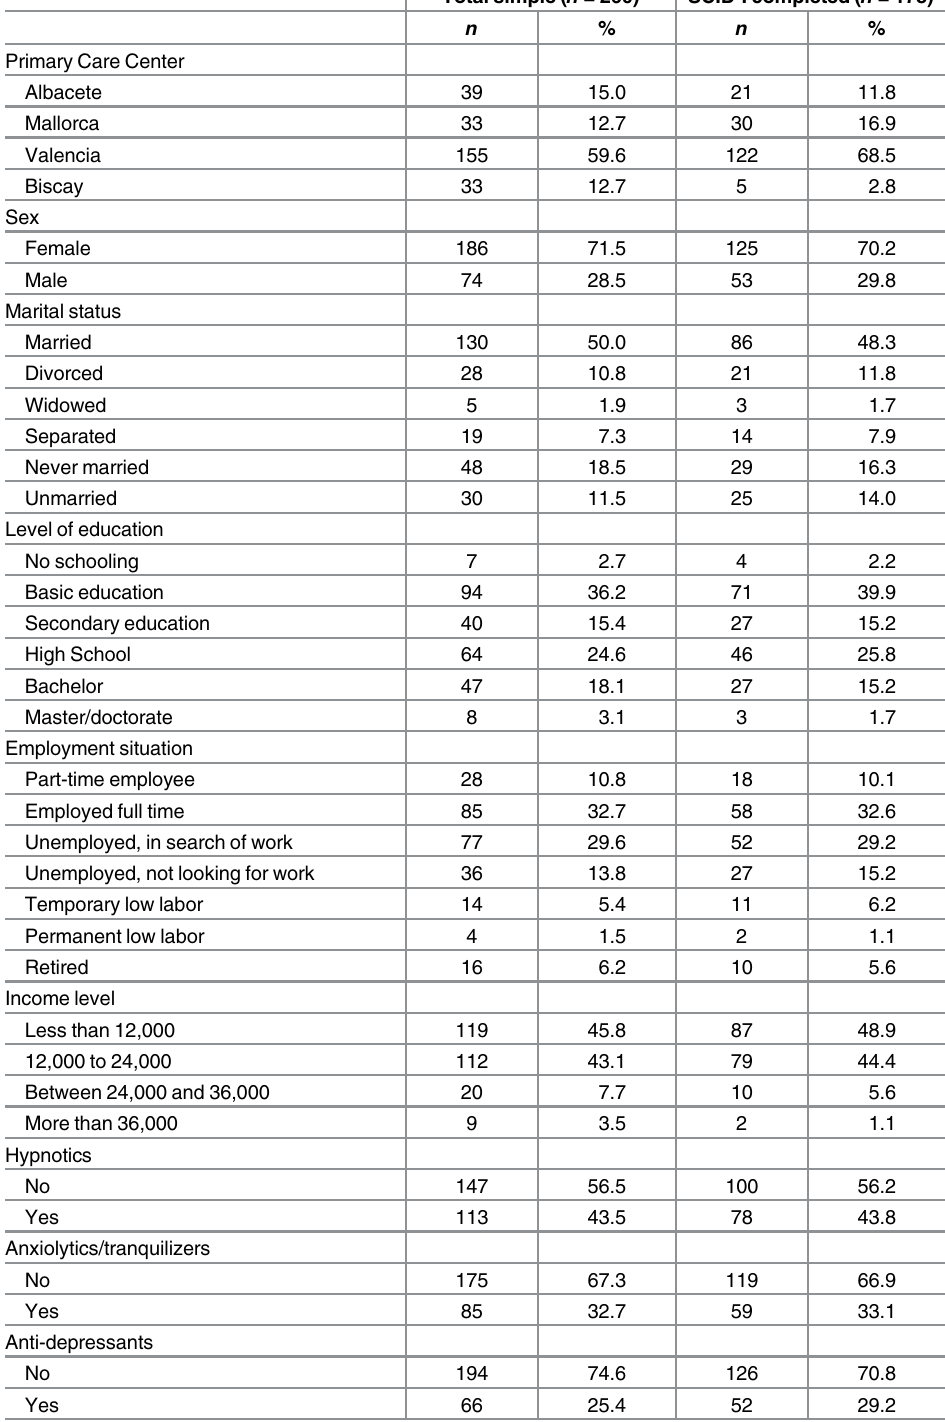
Table 1. Demographics and medication of total and SCID-I completed